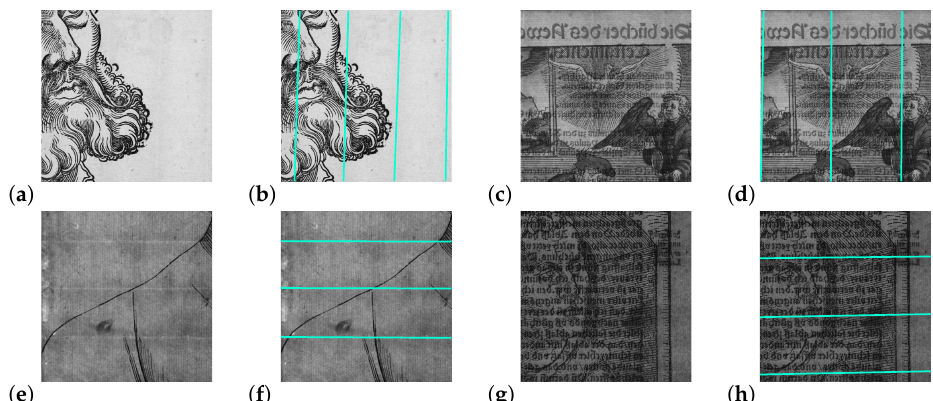
Figure 1. The paper structure in historical prints consists of chain and laid lines, which are perpen- dicular to each other. Examples using transmitted light photography ( a , c ) for vertical and ( e , g ) for horizontal chain lines are shown. Our ChainLineNet effectively detects the chain lines ( b , d , f , h ); even so, these are partly occluded by the ink of the artworks. Detail images: ( a ) Hans Sebald Beham, Martin Luther as Junker Jörg , Woodcut, Germanisches Nationalmuseum Nürnberg, H1933; ( c ) Un-